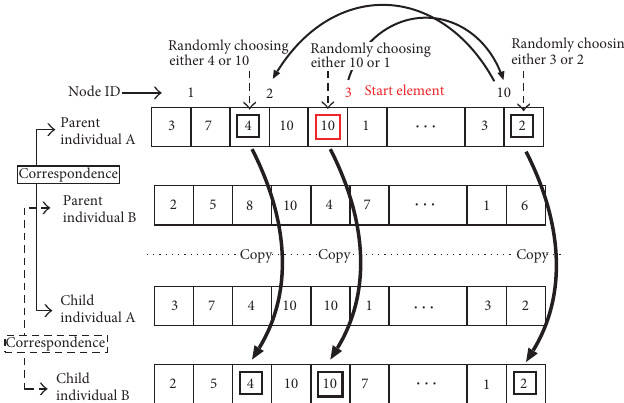
Figure 5: Example of node linkage crossover (NLX) when 𝑁 𝐶 = 2